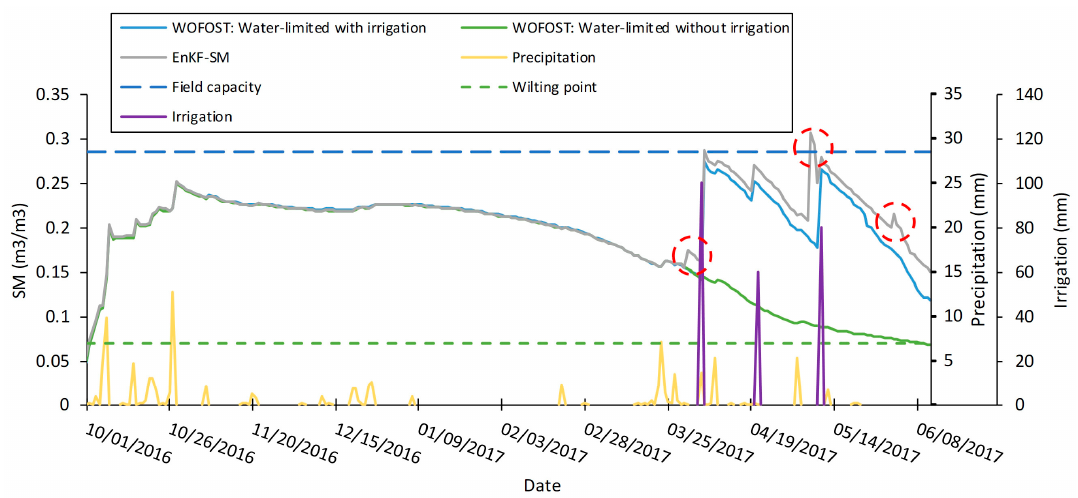
Figure 5. Validation of the retrieved soil moisture from the water cloud model; ( a ) 1 April, ( b ) 7 May, and ( c ) 1 June. Note: 55 sample points were used for validation.